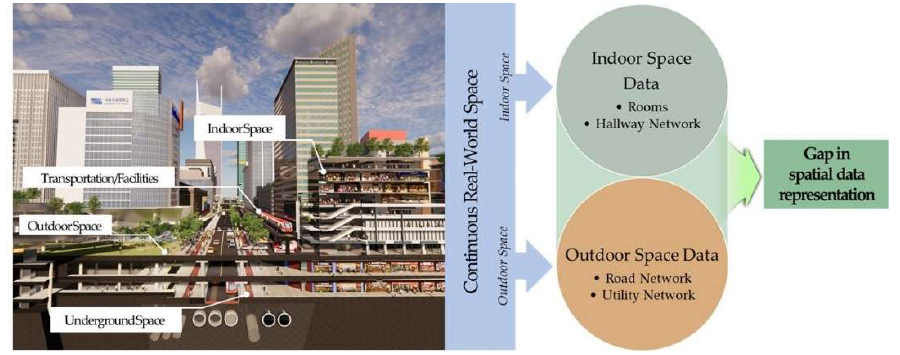
Figure 1. Representation of indoor and outdoor space using spatial data.